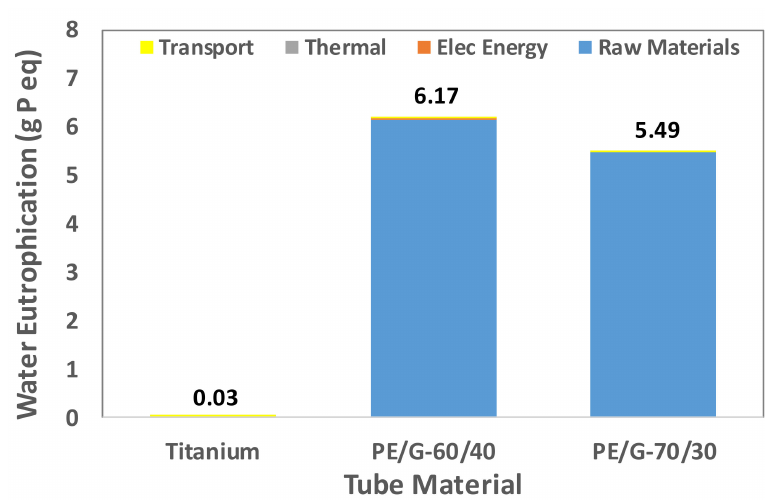
Figure 12. Freshwater eutrophication for titanium and polymer